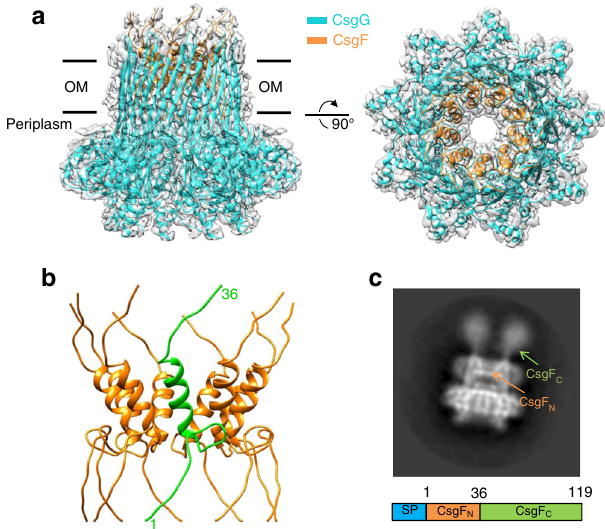
Fig. 1 Overall structure of the CsgFG complex. a Side (left) and top (right) views of the atomic model of the CsgFG complex superimposed with the corresponding cryoEM density map. Models of CsgG and CsgF are in cyan and orange, respectively. OM, outer membrane. b The nonameric CsgF N separated from the CsgFG complex. One of the CsgF N protomers is shown in green. c Representative 2D classi fi cation of the CsgFG complex. CsgF N and CsgF C are pointed by arrows. The schematic diagram of full length CsgF is shown at the bottom. SP signal